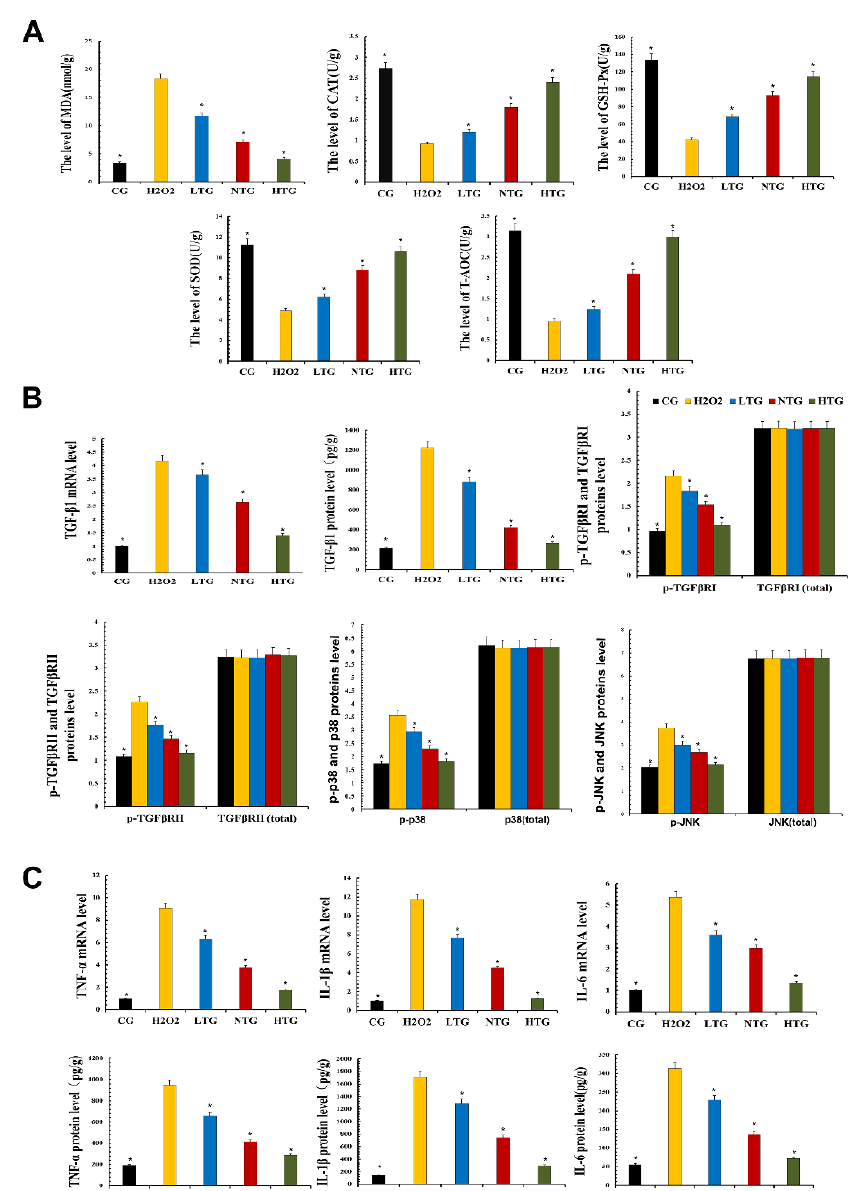
Figure 6. Oxidative stress and inflammatory response in MAC-T cells. Proteins’ expressions were detected with ELISA kits. RT-qPCR was used to verify mRNA expression. GAPDH was used as a control. ( A ) The measurement of oxidative damage and antioxidant capacity. ( B ) The expression of TGF- β1 mRNA and protein and the expression of proteins of the TGF- β signaling inflammatory signaling pathway. ( C ) The mRNA and protein expressions of inflammatory cytokines. CG, control group, the cells were routinely cultured. H 2 O 2 , hydrogen peroxide stimulation group. LTG, H 2 O 2 + 20 μg/mL tea polyphenols treatment group. NTG, H 2 O 2 + 40 μg/mL tea polyphenols treatment group. HTG, H 2 O 2 + 60 μg/mL tea polyphenols treatment group. The asterisk represents the com- parison with H 2 O 2 , and p < 0.05 is significantly different from H 2 O 2 . The experimental data represent the mean ± SD of three independent experiments.